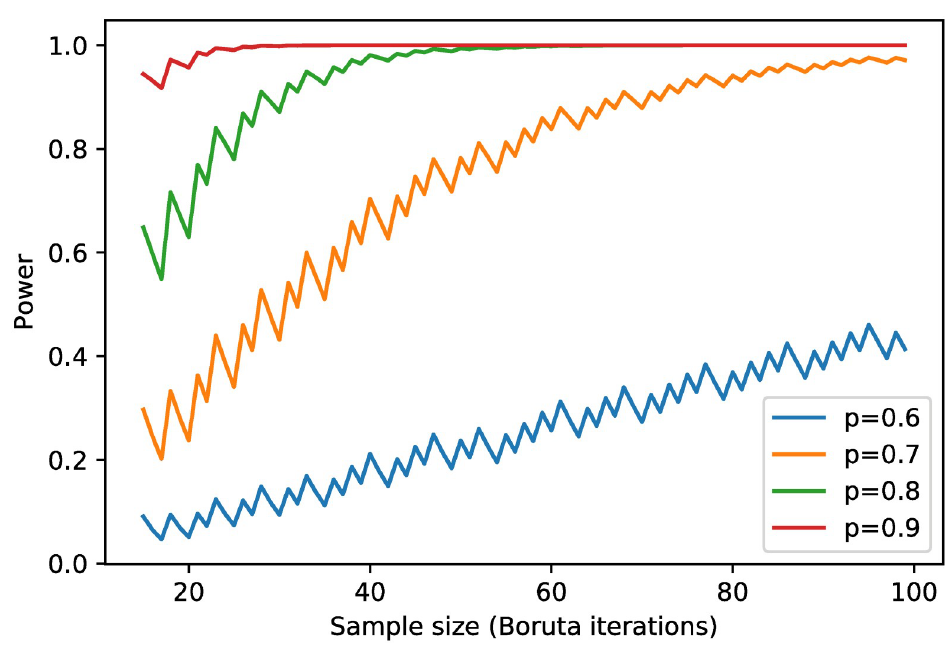
Fig 2. Power curves for the feature selection based on Boruta